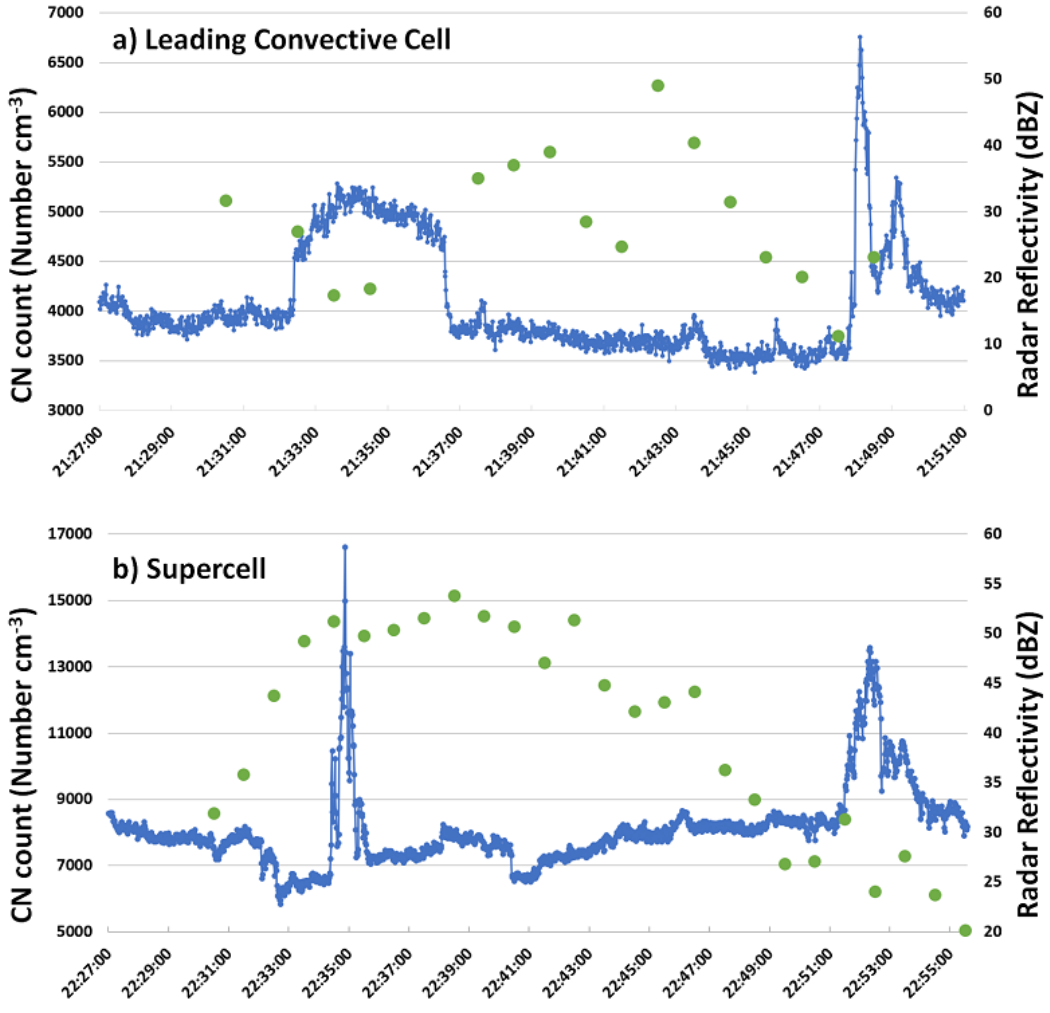
Figure 8. CN concentration (blue line) and disdrometer-calculated radar reflectivity (green dots) for ( a ) the leading convective cell and ( b ) the supercell.